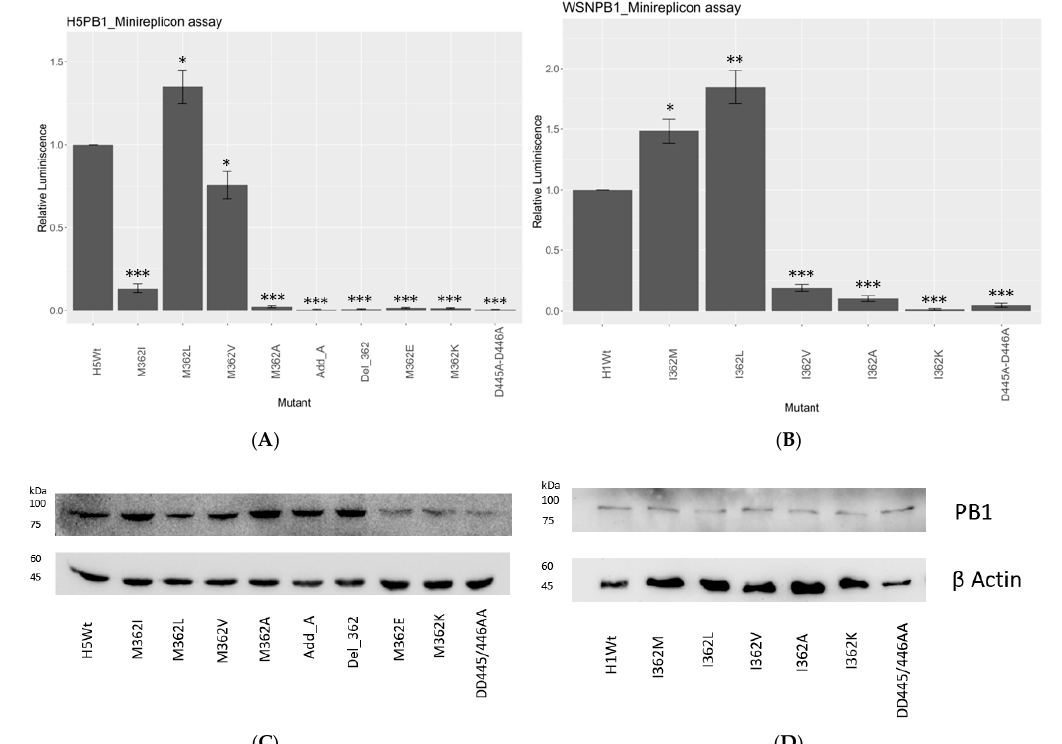
Figure 1. Minireplicon assay with H5N1 and H1N1 RNP. 293T cells were transfected with the plasmids expressing PB2, PA, NP and wild-type or mutant PB1 proteins, along with the FLuc promoter and the GFP control in ( A ) 156/97 background and ( B ) WSN background, respectively. The relative luminescence was determined by the ratio of luciferase/GFP signal, and the results of the mutants were normalized with the wild type in both setups. D445A-D446A mutant acted as the negative control. Error bars indicated the standard error of mean for at least three independent experiments. The p value was determined by Student’s t -test. (* = p value < 0.05; ** = p value < 0.01; *** = p value < 0.001). Mutants of 156/97 PB1 ( C ) and WSN PB1 ( D ) showed similar expression levels after normalizing to the corresponding β actin controls (Supplementary Figure S4A,B).